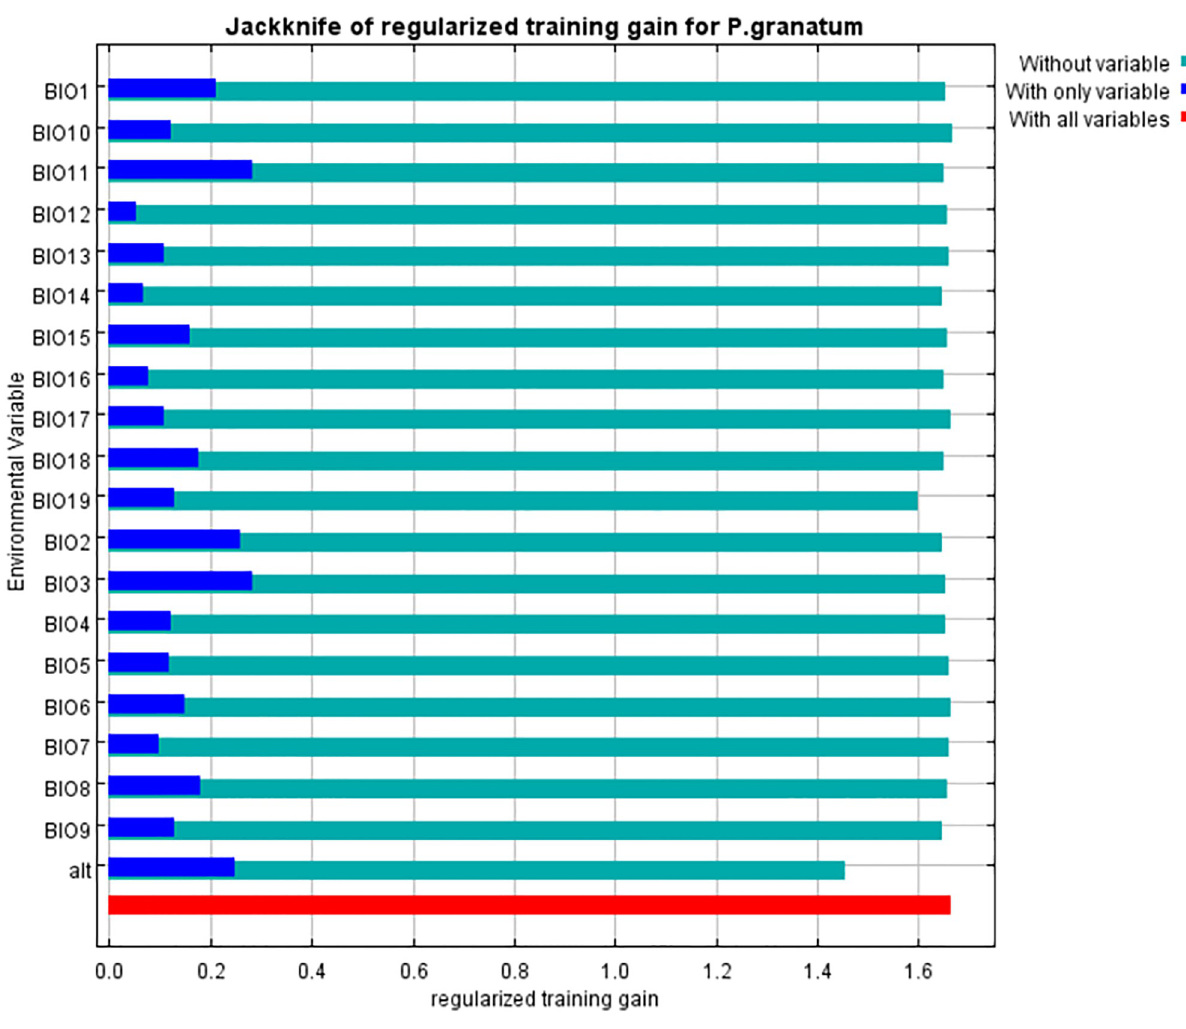
Fig 11. Jackknife test for evaluating the relative importance of climate variables on the distribution of pomegranate using training gain. Values are average on 10 replicate MaxEnt runs.